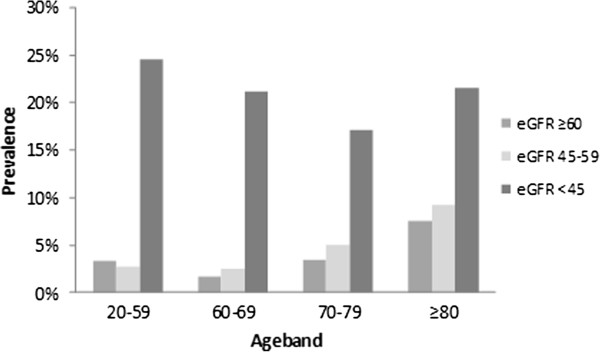
Age-specific prevalence of anaemia in CKD.